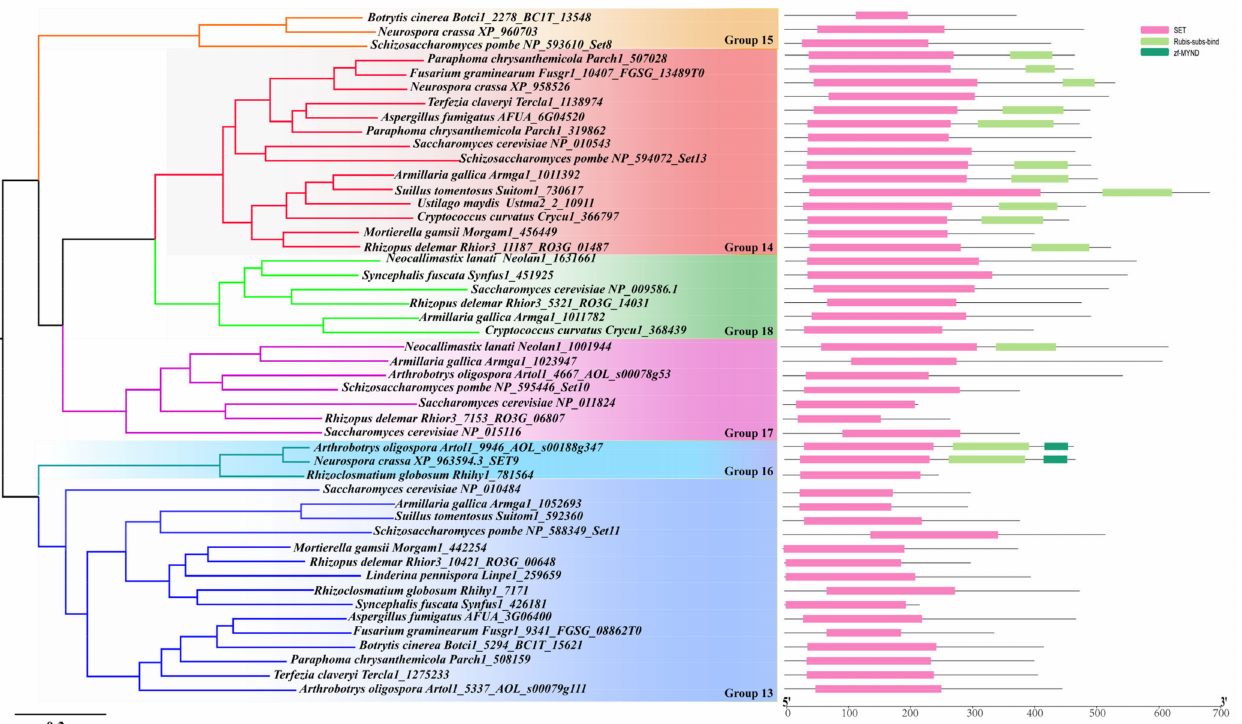
Figure 6. Phylogenetic analysis and domain organization of the Cluster 2 SET domain sequences from 20 representative 20 fungal species. The protein domains were labeled with different colors based on the domain type. Domain organization of SET-domain-containing proteins was detected by InterProScan 5.0 (http://www.ebi.ac.uk/interpro/) and MEME suite (https://meme-suite.org/ meme/) with default parameter settings. Phylogenetic analyses were performed using NJ with MEGA X and ML analysis with